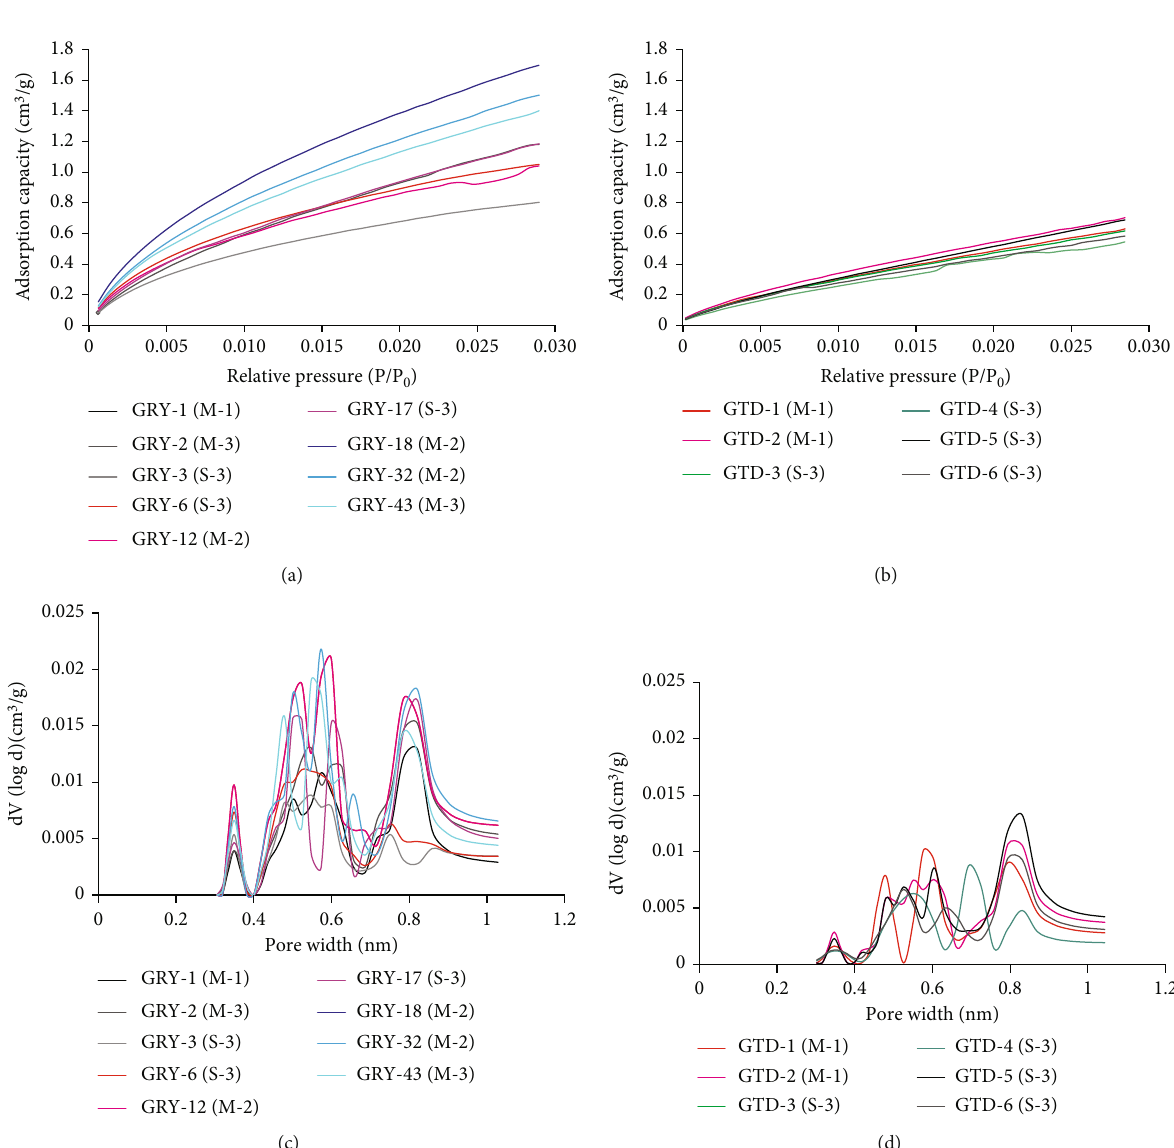
adsorption curve of Devonian shale samples in 2 pore diameter distribution 2